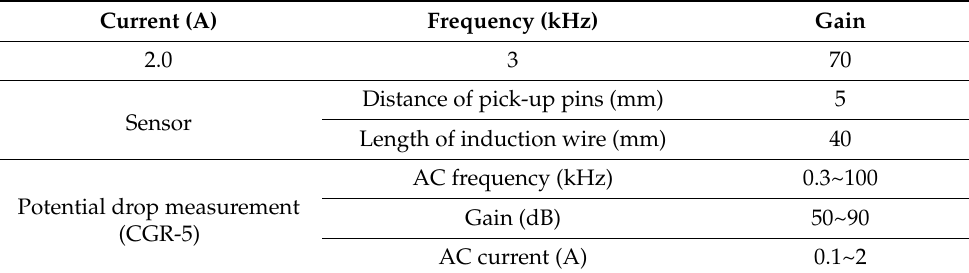
Table 3. Mechanical properties of wheel specimens.